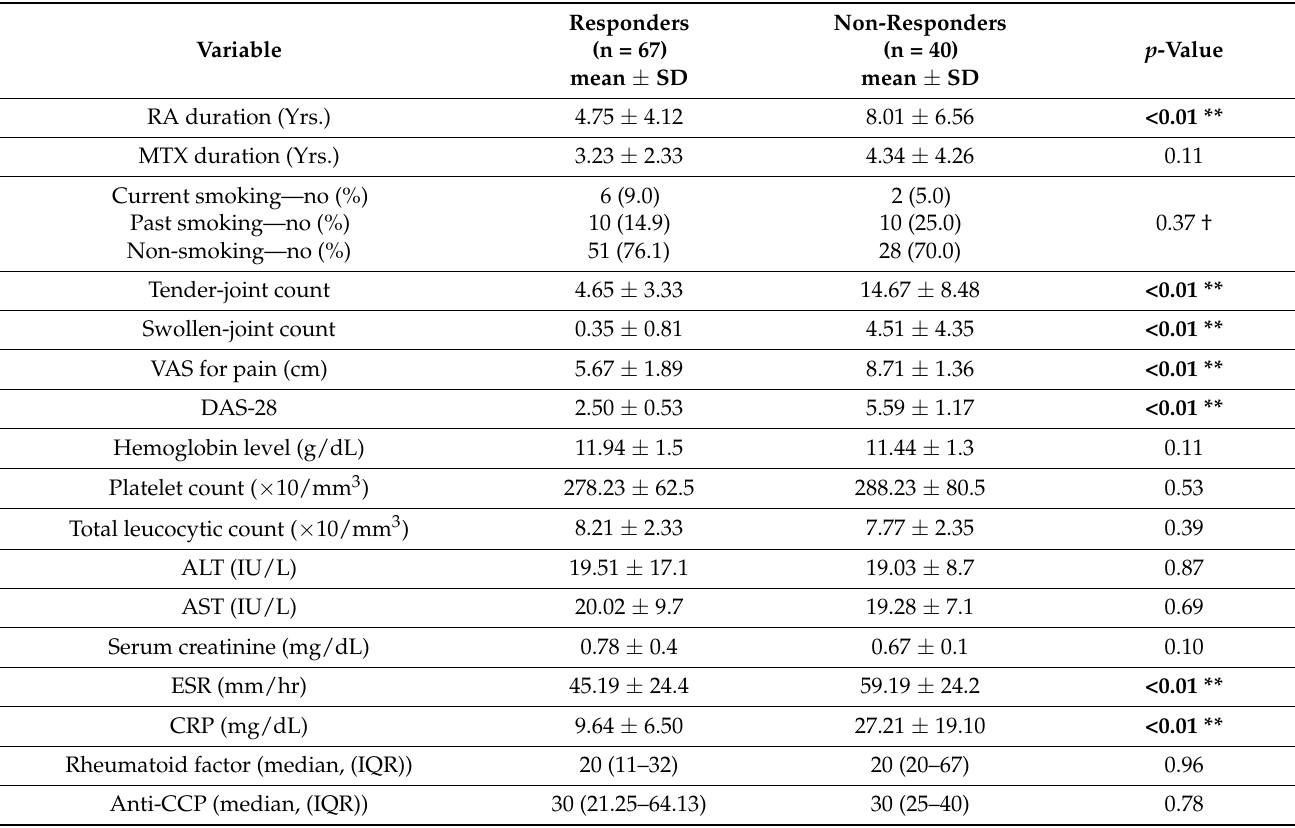
Table 3. The clinical and laboratory features of rheumatoid arthritis patients’ responders vs. non- responders to